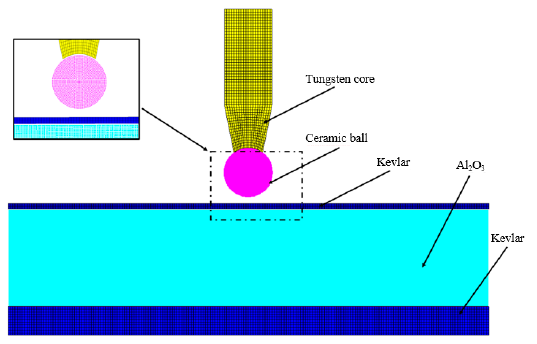
Figure 5. Simulation model.